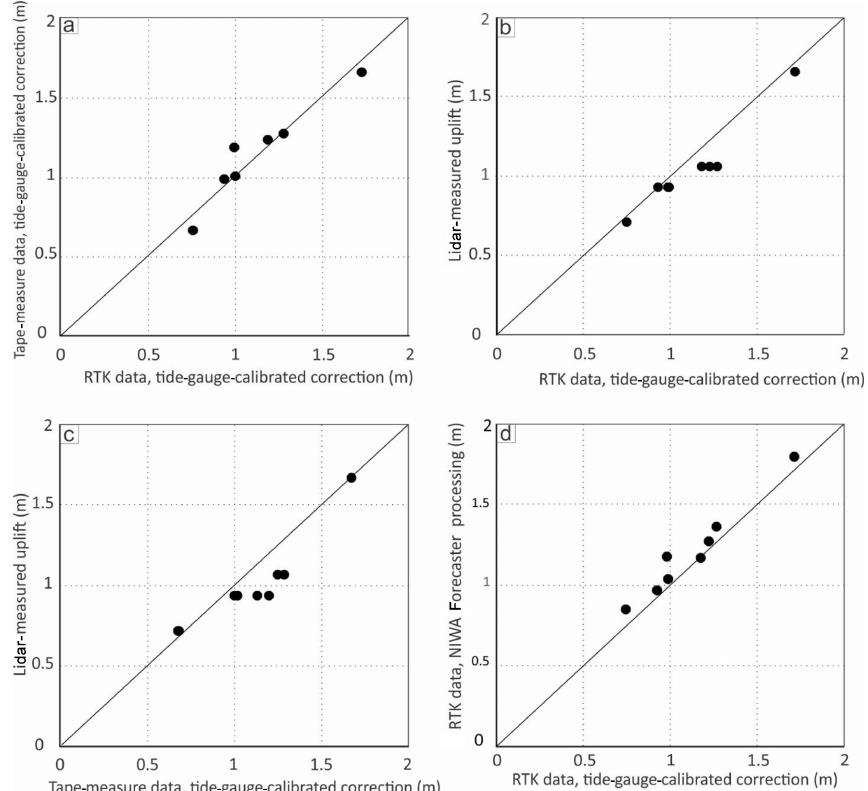
Figure 8. Cross plots of data collection and processing methods. (a) RTK and tape-measure uplift data processed using the tide-gauge correction method. (b) RTK uplift data, processed using the tide-gauge correction method, plotted against differential lidar uplift data. (c) Tape-measure uplift data, processed using the tide-gauge correction method, plotted against differential lidar uplift data. (d) RTK uplift data, processed using the tide-gauge correction method, plotted against the NIWA Forecaster tide-chart correction